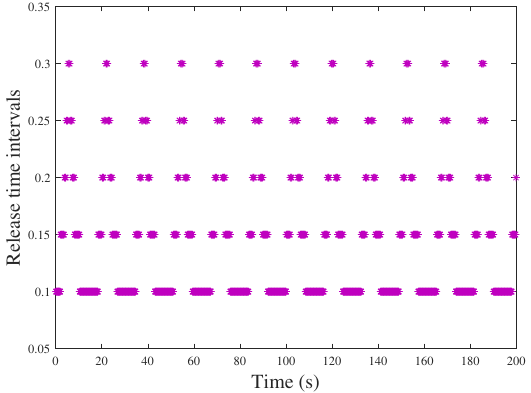
Figure 8. Release time intervals corresponding to a stable periodic solution.